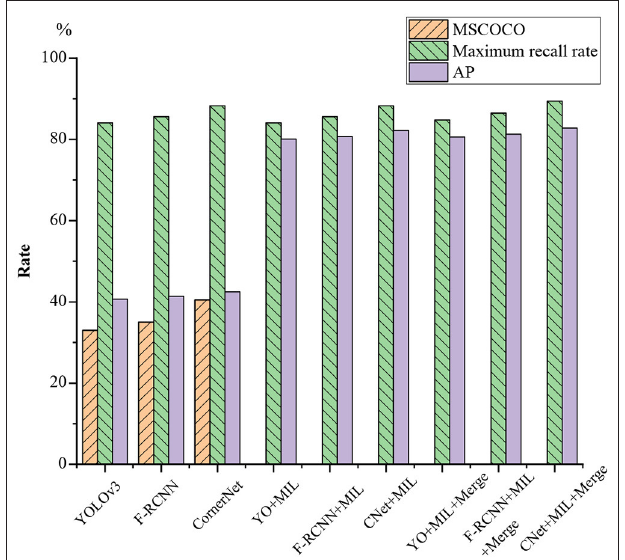
FIGURE 13 | Football video detection results.